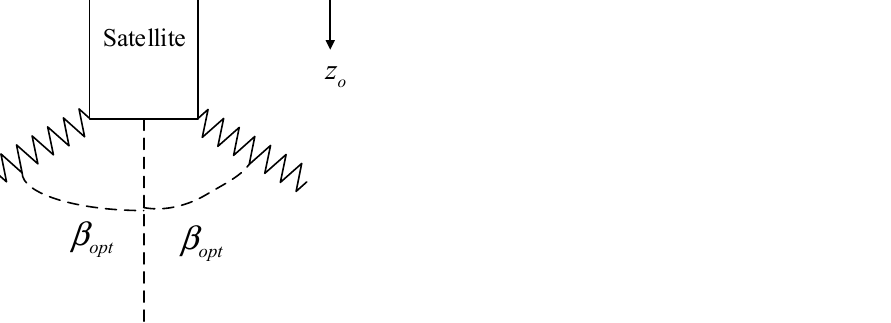
Figure 7. The installation location and geometry configuration of two helical antennas.